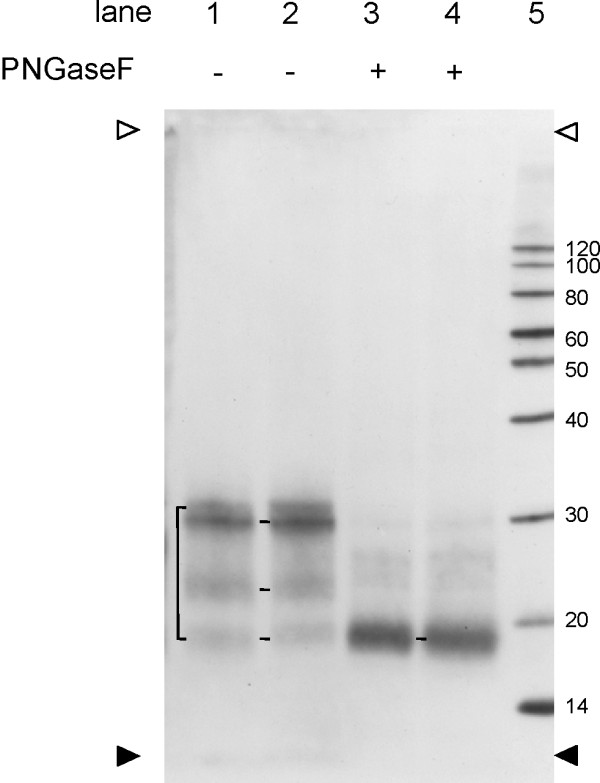
Western blotting of homogenates from scrapie positive tonsil and retropharyngeal lymph node. Tonsillar (lanes 1, 3) and medial retropharyngeal lymph node (lanes 2, 4) material digested with proteinase K was analyzed by WB and developed with monoclonal antibody P4 (0.2 μg/ml). Enzymatic treatment with PNGaseF is indicated. Lanes 1–4: Applied amounts 450 μg TE/lane. Lane 5: molecular weight markers. Position of markers are in kDa. Other symbols: open arrowhead for top of gel, bold arrowhead for front of bromphenol blue, bracket for migration position of PrPres triplet, small lines for the three individual PrPres polypeptides in the triplet as discussed in the Results section. Position of markers is in kDa. Band at 14 kDa represents lysozyme from SeeBlue Mark12 which is bound by anti-mouse alkaline phosphatase conjugate.